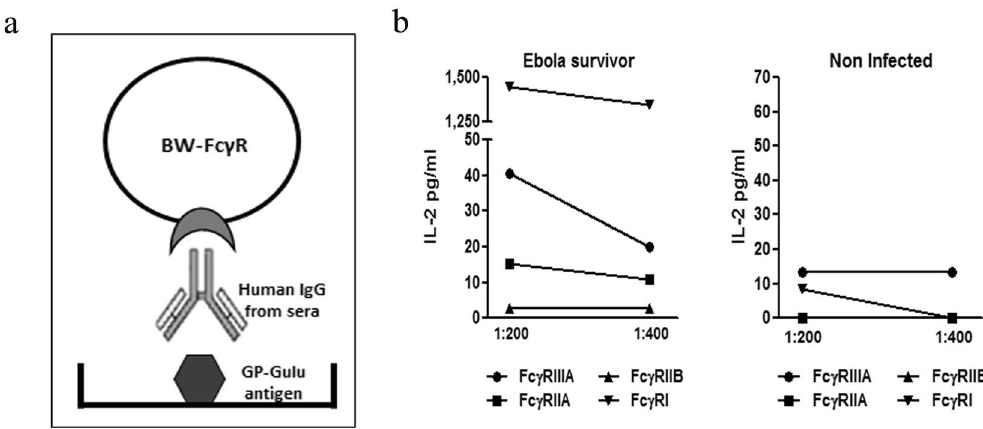
Figure 3. Binding of Ebola GP-specific antibodies found in survivors sera to Fc γ R reporters. Serum samples from non-infected controls was compared to SUDV survivors by its BW-Fc γ R activation capacity. ( a ) Diagram of antigen specific IgG mediated activation of BW-Fc γ R cells. Coating of plates with GP-Gulu antigen (5 µ g/ ml), addition of human sera following seeding with reporter cells at 50 * 10 3 cells/well. mIL-2 secretion of activated cell determined by ELISA after 16 h incubation. ( b ) Serum samples from SUDV survivor and non- infected patient diluted 1:200 and 1:400 were added to pre-coated plates with GP-Gulu antigen (5 µ g/ml). After activation assay, mIL-2 secretion was determined by ELISA after 16